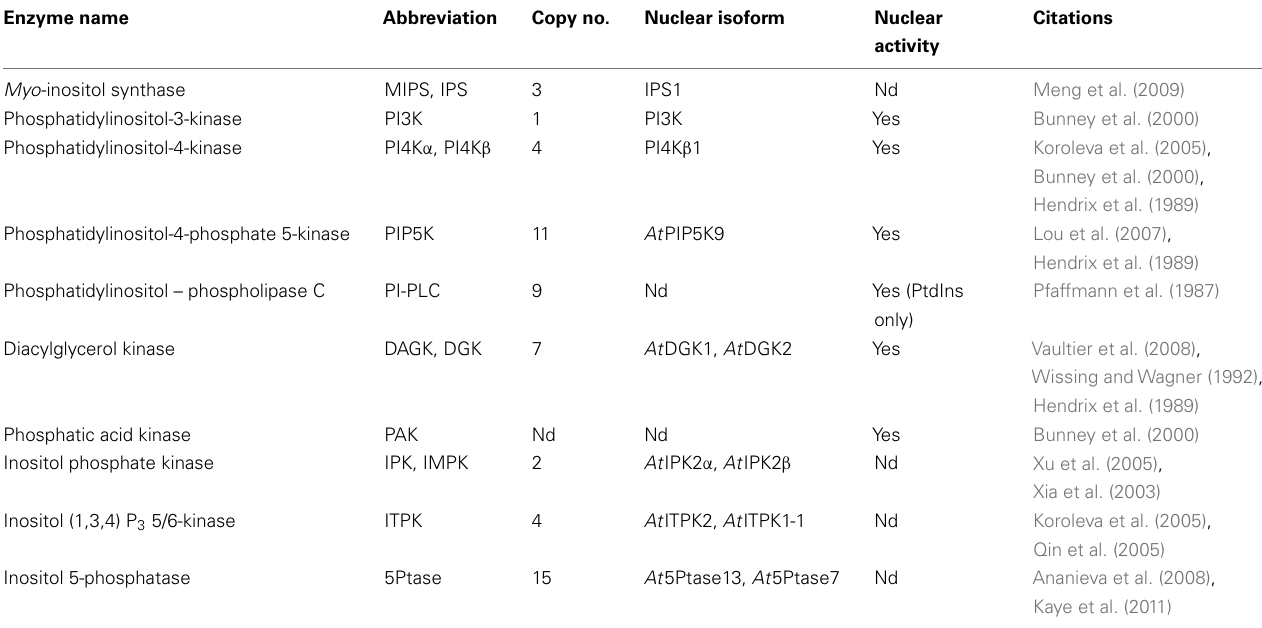
Table 1 | Phosphoinositide pathway enzymes reported in plant